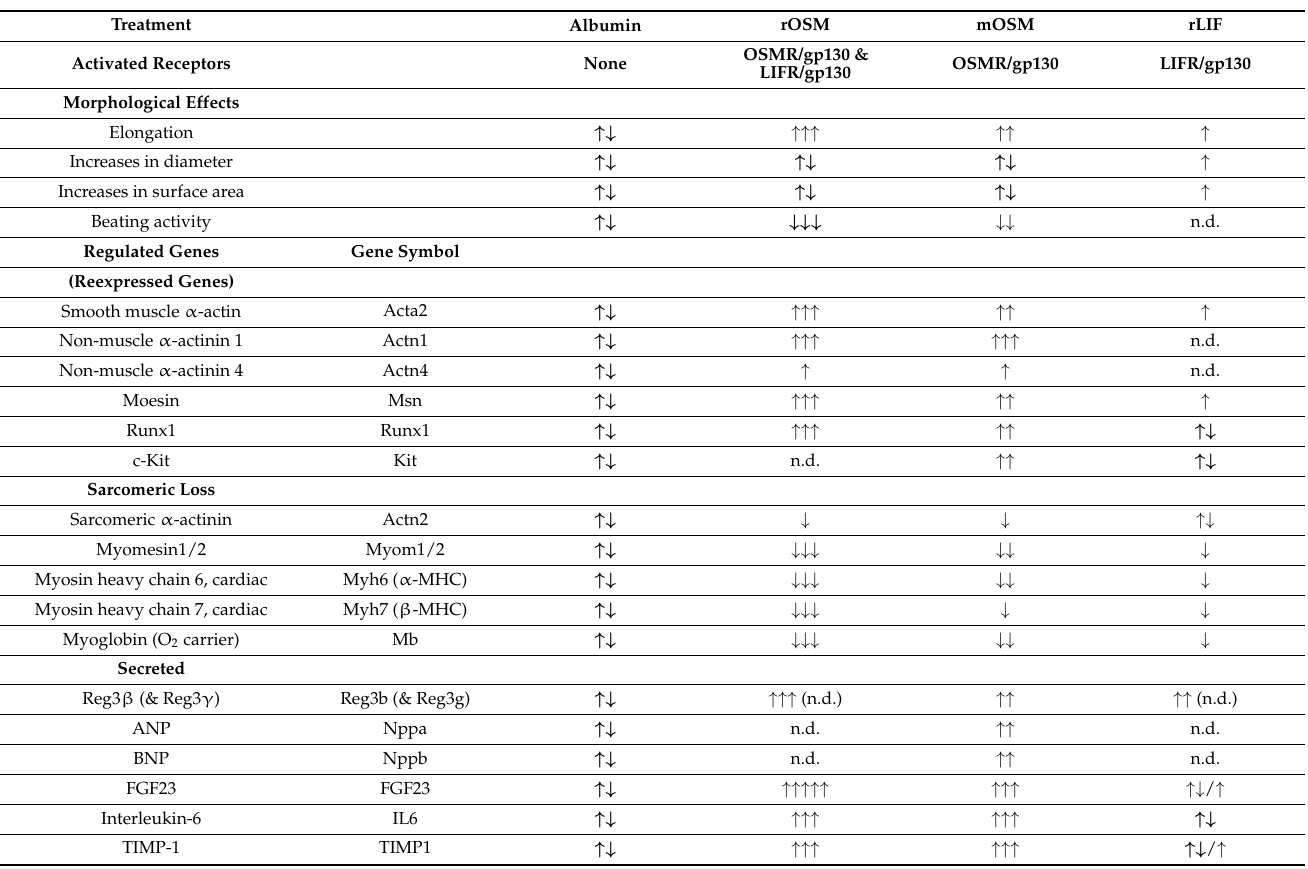
Table 1. Characteristic effects of activated oncostatin M type I (LIFR/gp130) and type II (OSMR/gp130) receptor complexes in cultured adult rat cardiomyocytes. The relative magnitude of effect is indicated by slight or no change ( ) and the increasing number of small arrows demonstrates the increasing ↑↓ or decreasing strength of cardiomyocyte responses. With an extended culture time, there might be a slight increase ( / ). Not determined is abbreviated as n.d. All effects can also be observed in mouse ↑↓ ↑ models of myocardial diseases and human diseased hearts as discussed in the text. Except for c-Kit, which was detected only by RT-PCR (due to the lack of a functioning anti-rat antibody), all regulated genes were observed on the mRNA as well as at the protein level. Explanation is provided in the